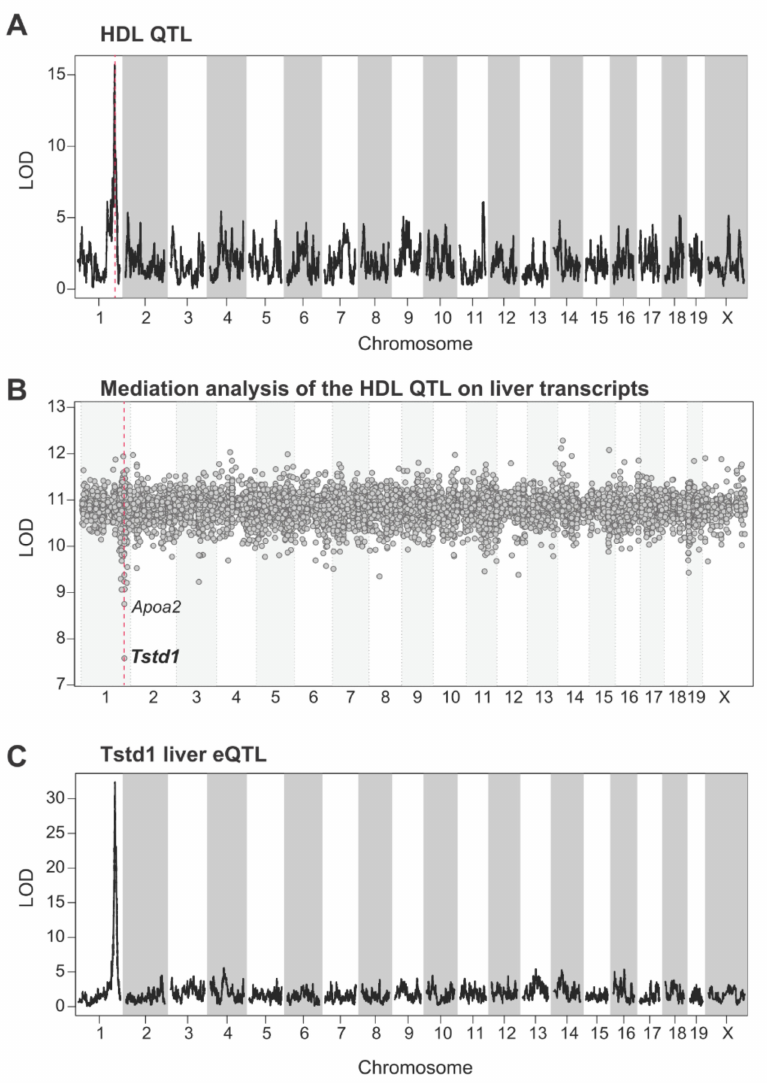
Figure 2. QTL and mediation analysis revealed Tstd1 as a potential modulator for plasma HDL levels in the DO mouse cohort. ( A ) QTL plot showed the genome-wide linkage of plasma HDL levels in the DO mouse cohort. Chromosomes are represented across the x-axis and the significance of QTLs (log of odds, LOD) is represented on the y-axis. The vertical red dashed line indicates the QTL peak on chromosome 1. ( B ) Mediation analysis identified the possible mediators for the HDL QTL on chromosome 1. Genes are plotted across the x-axis based on their genetic positions on chromosomes. The conditional QTL scores for all genes in the mediation analysis are represented on the y-axis. The vertical red dashed line indicates the QTL peak for HDL on chromosome 1. ( C ) eQTL plot for Tstd1 in the liver of the DO mouse cohort. Tstd1 mapped a cis-eQTL at the same locus of the QTL for HDL